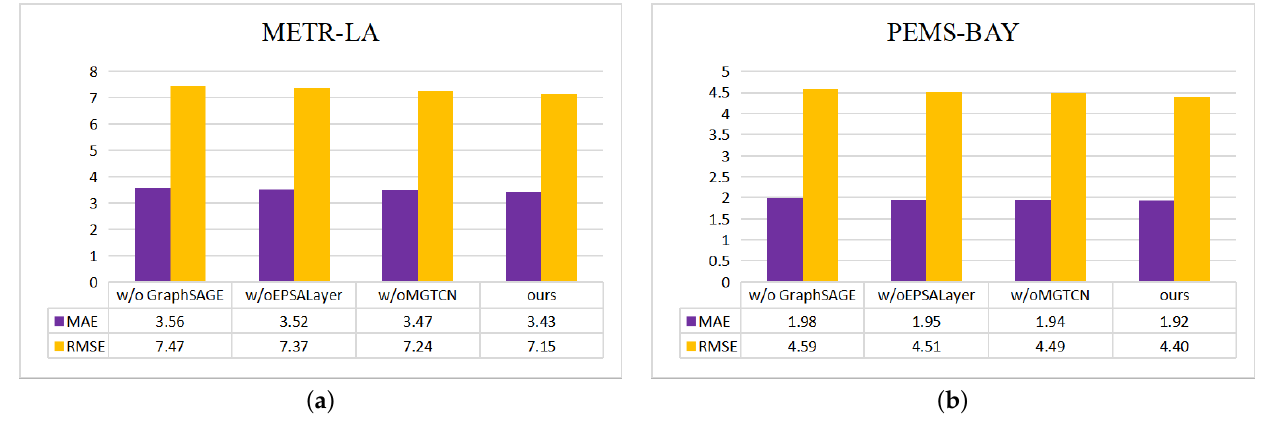
Figure 10. Experimental results of different ablation modules: ( a ) METR-LA; ( b ) PMES-BAY.